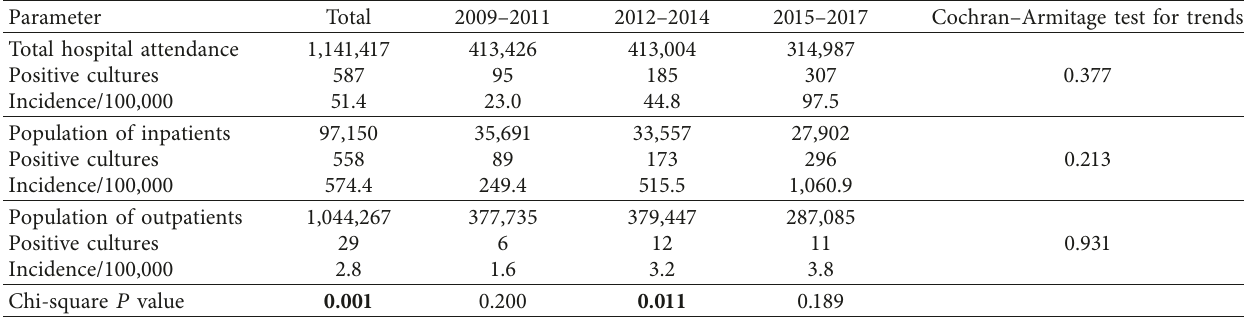
Parameter Cochran–Armitage test for